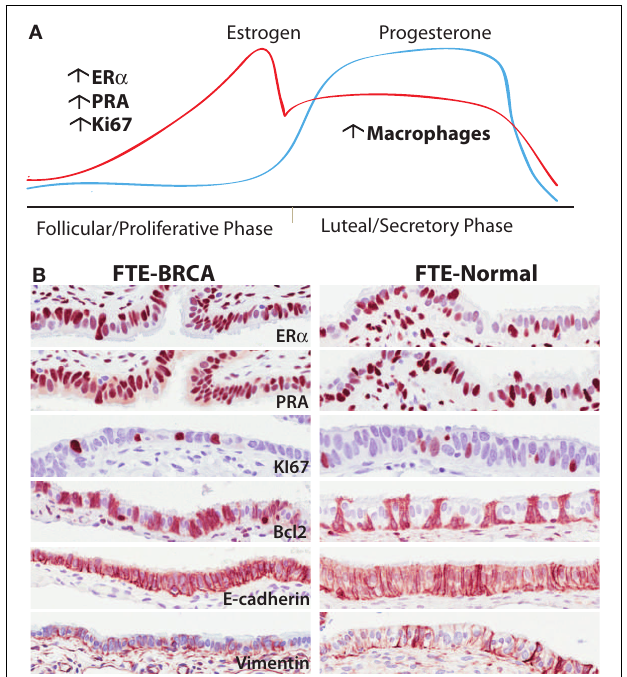
FIGURE 3 | (A) The different phases of the ovarian cycle in pre-menopausal women is the dominant effect on gene transcription in epithelia of normal fallopian tubes in BRCA mutation carriers.Translationally, there are more cells expressing ER, PR in the follicular phase of the cycle independent of mutation status. Similarly there are significantly more cells responding to the mitogenic effects of estrogen observed by an increase in proliferation. In the post-ovulatory phase, there is an observed increase in macrophages in both BRCA mutation carriers and non-carriers. (B) Representative images of proteins expressed in normal FTE-BRCA and FTE-normal that seemingly look and express these proteins similarly. Underlying these morphological similarities is a potential haploinsufficiency predisposing FTE-BRCA to cytotoxic stresses.